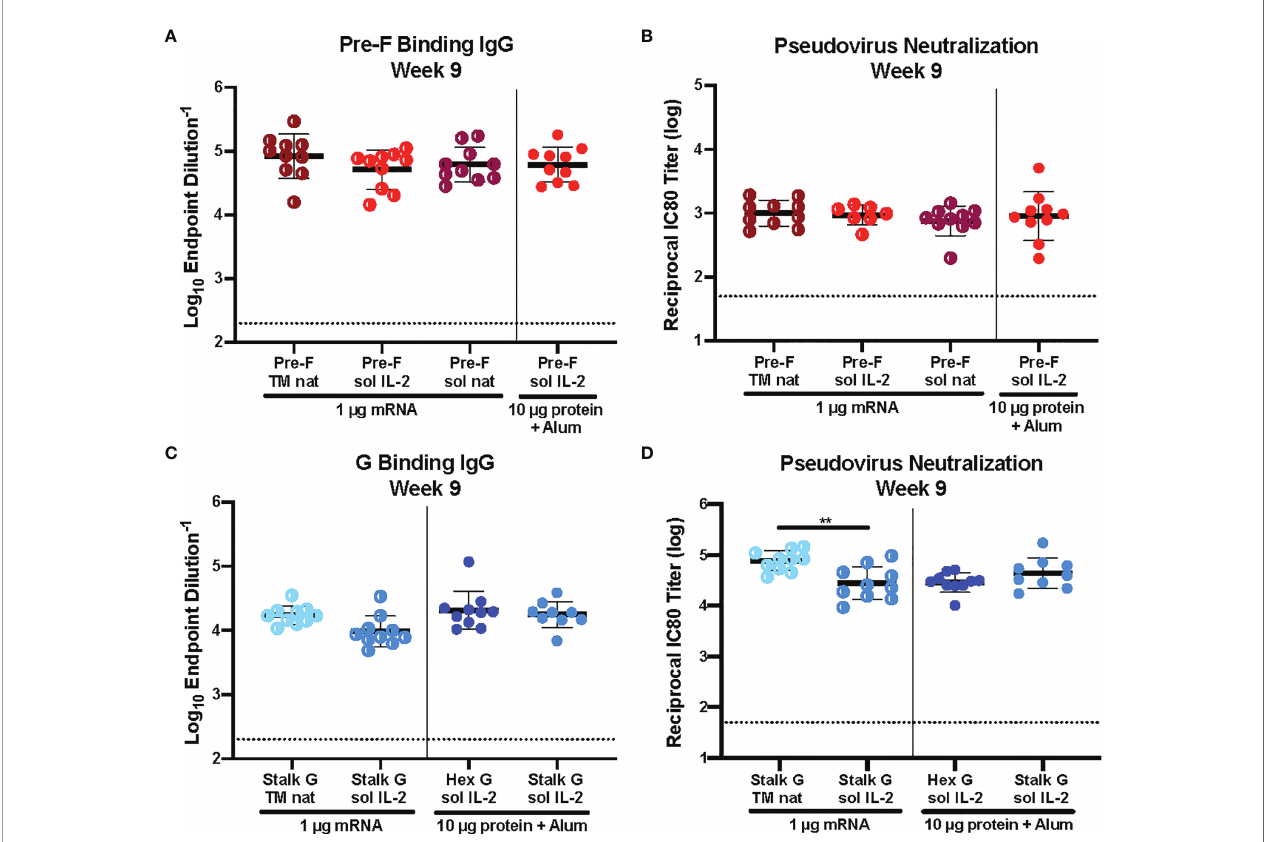
FIGURE 2 | Immunogenicity of mRNA Immunogen-Speci fi c Design Elements. (A, C) Serum samples 6 weeks post-boost were assessed for NiV pre-F speci fi c IgG (A) or monomeric G-speci fi c IgG (C) by ELISA. Line represents mean of all animals in each group +/- standard deviation. (B, D) VSV D G-luciferase pseudovirus neutralization assays were performed on individual mouse sera collected 6 weeks post-boost. The log 10 reciprocal IC 80 neutralization titer for each sample was calculated by curve fi tting and non-linear regression using GraphPad Prism. Line represents mean of log 10 reciprocal IC 80 dilution +/- standard deviation. P values were calculated using one-way ANOVA with Tukey ’ s multiple comparisons test (**p < 0.01). Dotted lines represent assay limits of